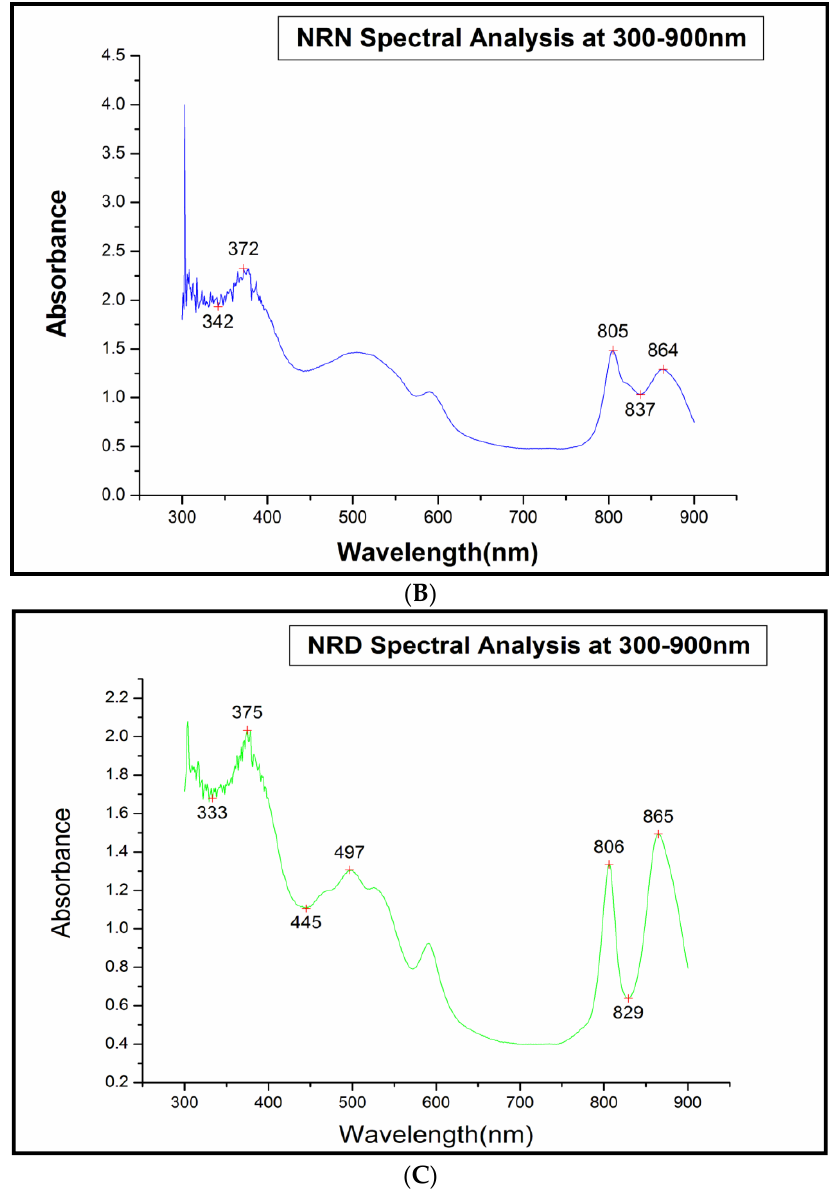
Figure 2. ( A ) Spectral analysis of R. palustris SMR 001; ( B ) Spectral analysis of R. palustris NR MPPR; ( C ) Spectral analysis of R. faecalis N Raju